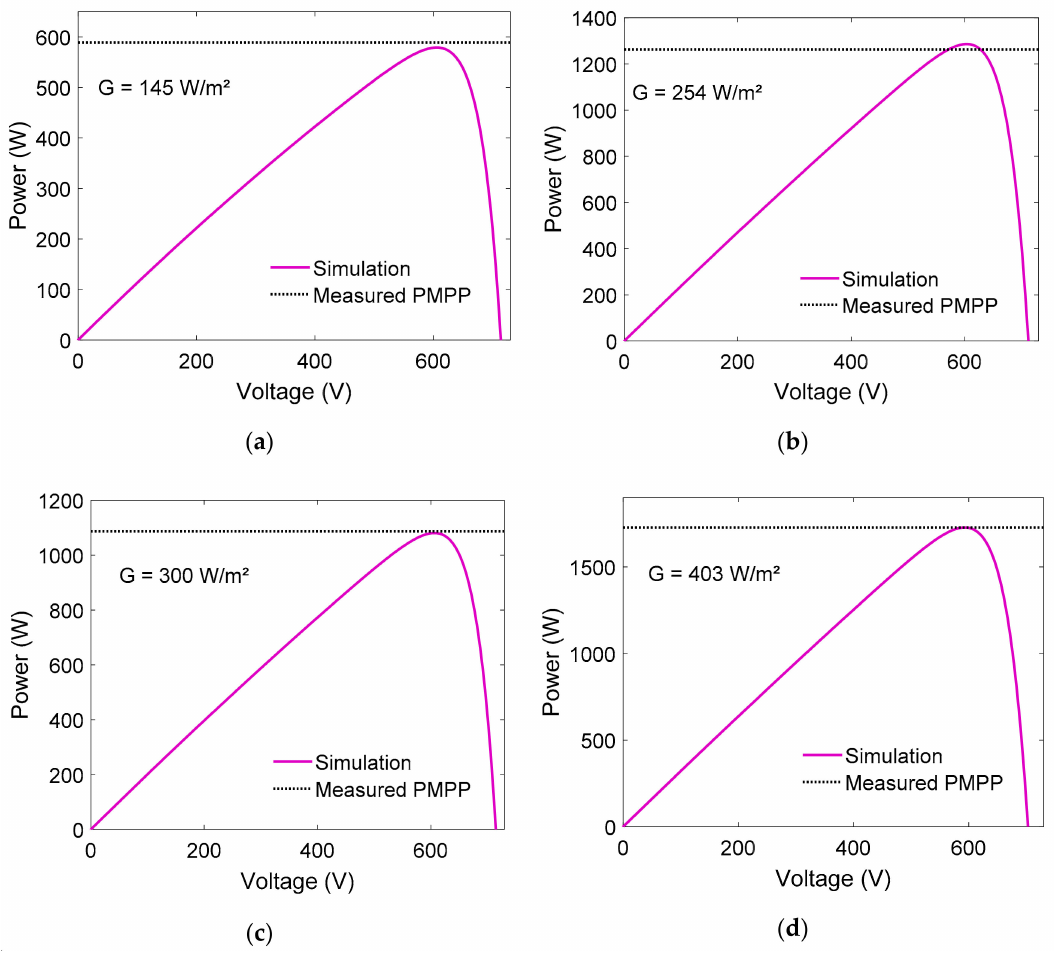
Figure 6. P–V curves for System 1 ( a ) G = 145 W / m 2 , ( b ) G = 254 W / m 2 , ( c ) G = 300 W / m 2 , and ( d ) G = 403 W / m 2 .